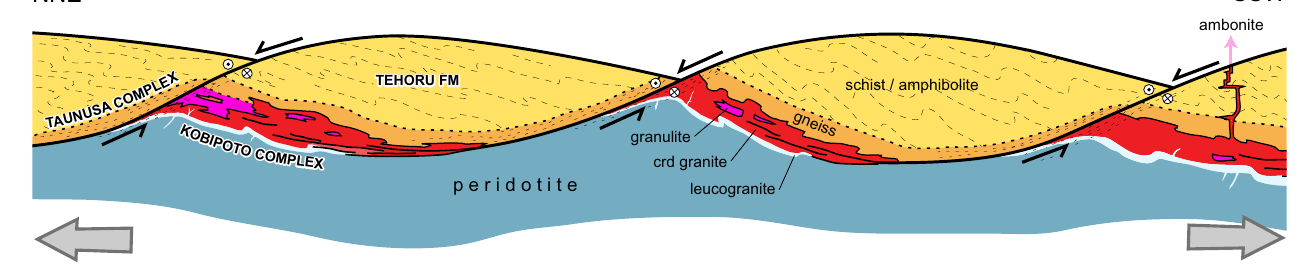
Fig. 21a. Detachment faulting model (schematic) proposed for Seram to explain mantle exhumation by extreme extension driven by Banda Arc slab rollback. The relationship between the Kobipoto Complex (granulites, granites, and associated peridotites), the Taunusa Complex (gneisses and migmatites), and the Tehoru Formation (pre-metamorphosed mica schists and amphibolites) is shown. The detachment faults may have subsequently been reactivated as left-lateral strike-slip faults as observed in the Kawa Fault Zone. See text for discussion.